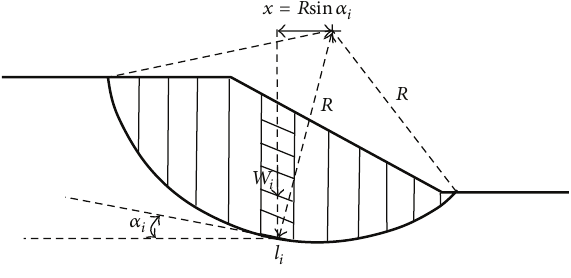
Figure 1: Fellenius’ method of